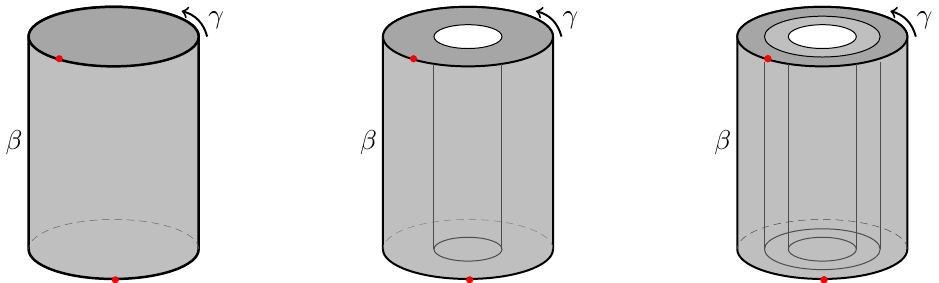
Figure 1 . [From left to right] A solid cylinder, a cylindrical annulus and two annuli glued together in three dimensions. After rotating the tops by a twist angle, they are identified with the bottoms (red dots), leading to a solid torus and toroidal